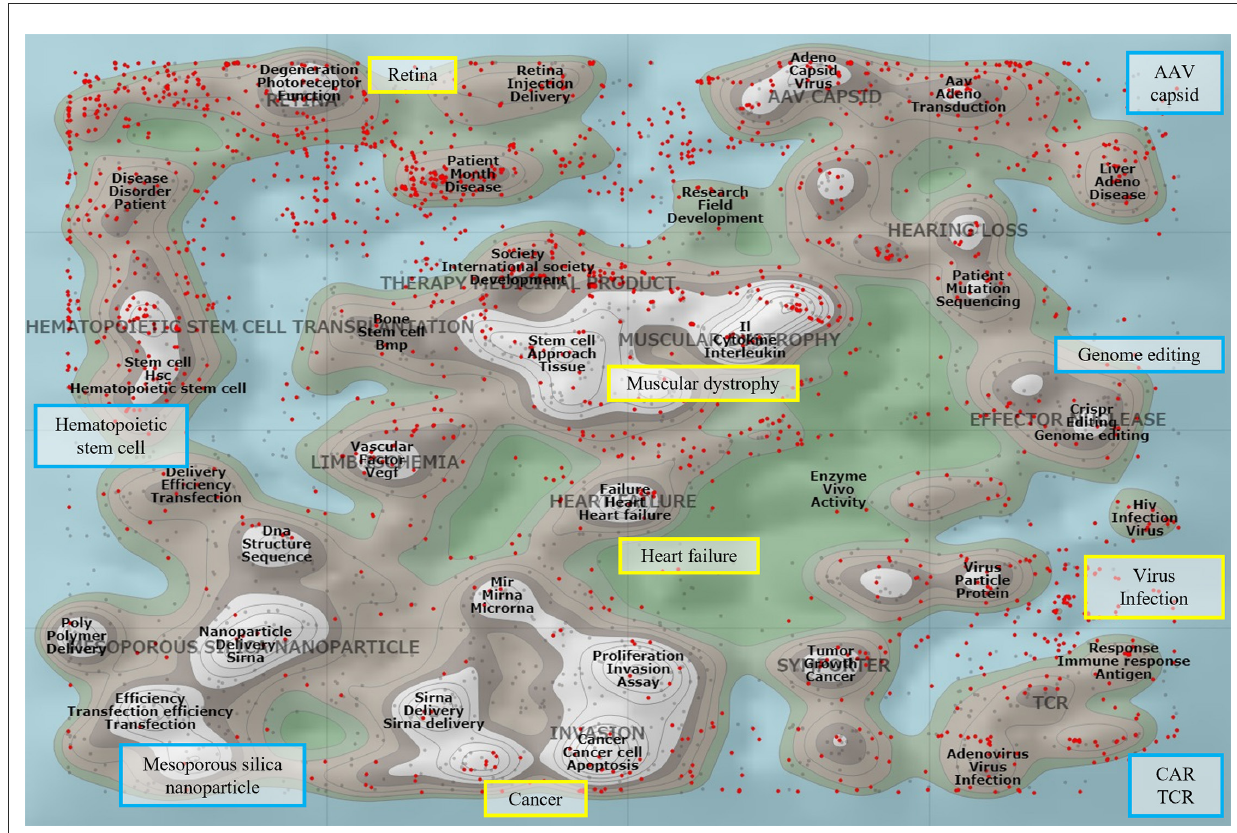
FIGURE1 The literature landscape of gene therapy. The ThemeScape map, an analytical tool in Derwent Innovation (Clarivate Analytics), conducts text-mining-based literature clustering. Common conceptual terms are displayed on a two-dimensional map which shows the relative relationship of one article to another, with peaks representing a concentration of documents. The map comprising 14,770 publications was visualized by the extracted terms from the titles and/or abstracts relevant to the gene therapy articles in Web of Science between 2015 and 2022. It depicts high-density clusters for the disease areas (rectangle bordered in yellow) and technological domains (rectangle bordered in blue), such as chimeric antigen receptor (CAR), T cell receptor (TCR), genome editing, AAV capsid, and mesoporous silica nanoparticles. The red dots represent the articles identified with the terms “clinical or